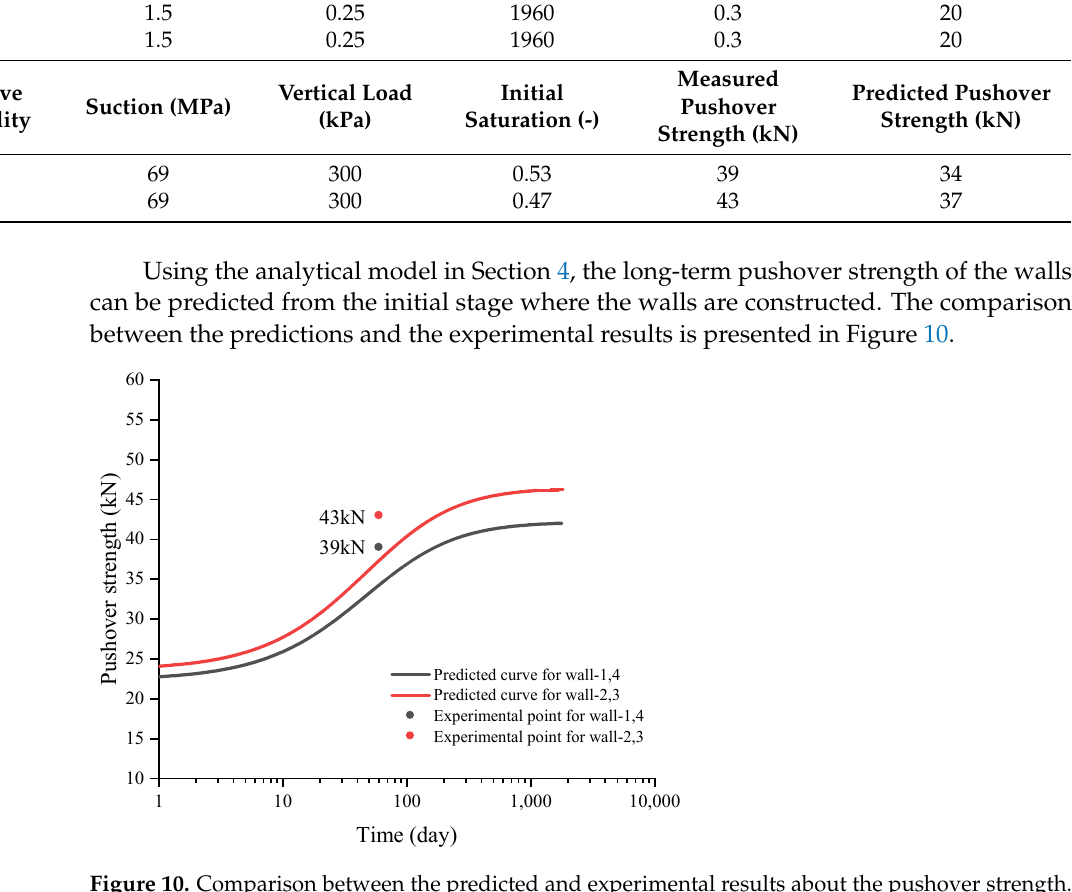
Predicted curve for wall-1,4 Predicted curve for wall-2,3